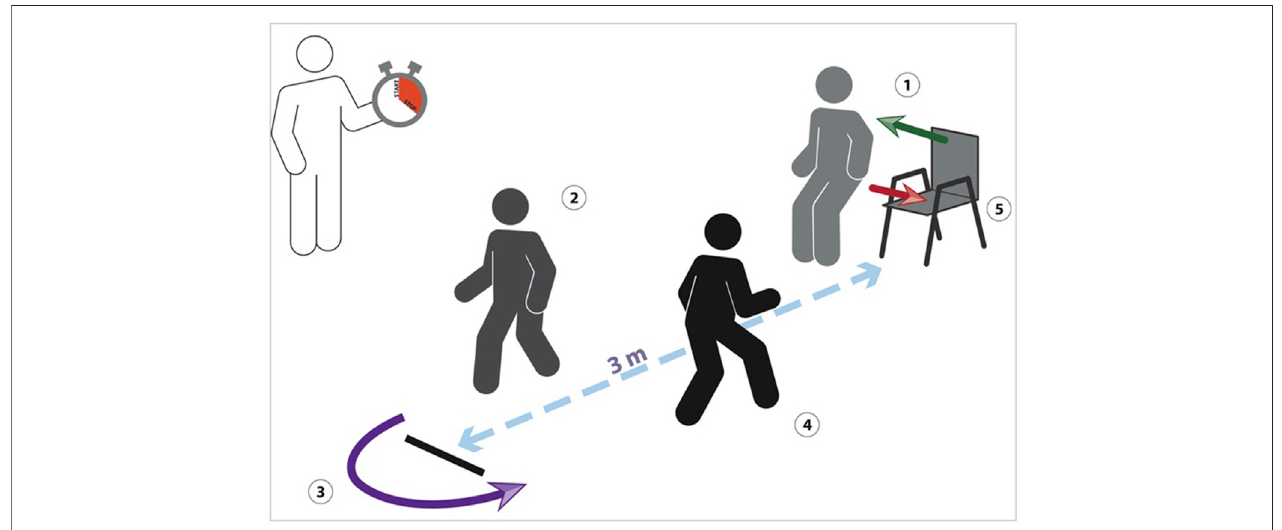
FIGURE 1 | The classical TUG, where the therapist measures the time taken by the patient to perform the task.